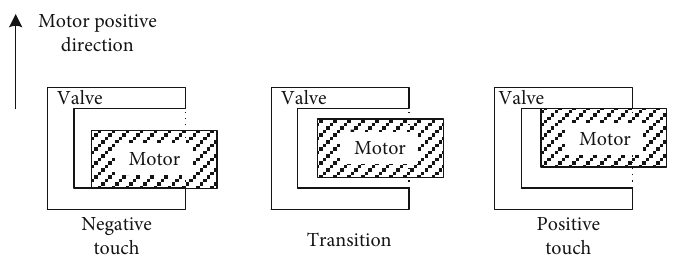
Figure 7: Schematic of backlash touch